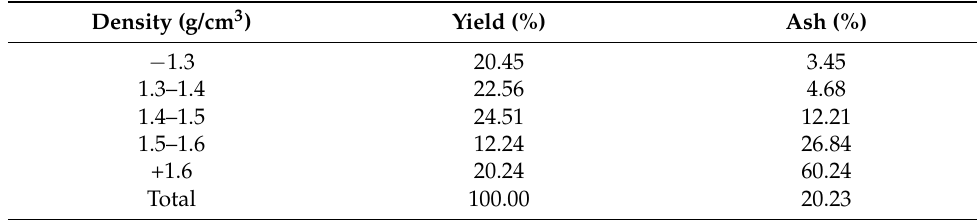
Table 2. Density distribution of raw